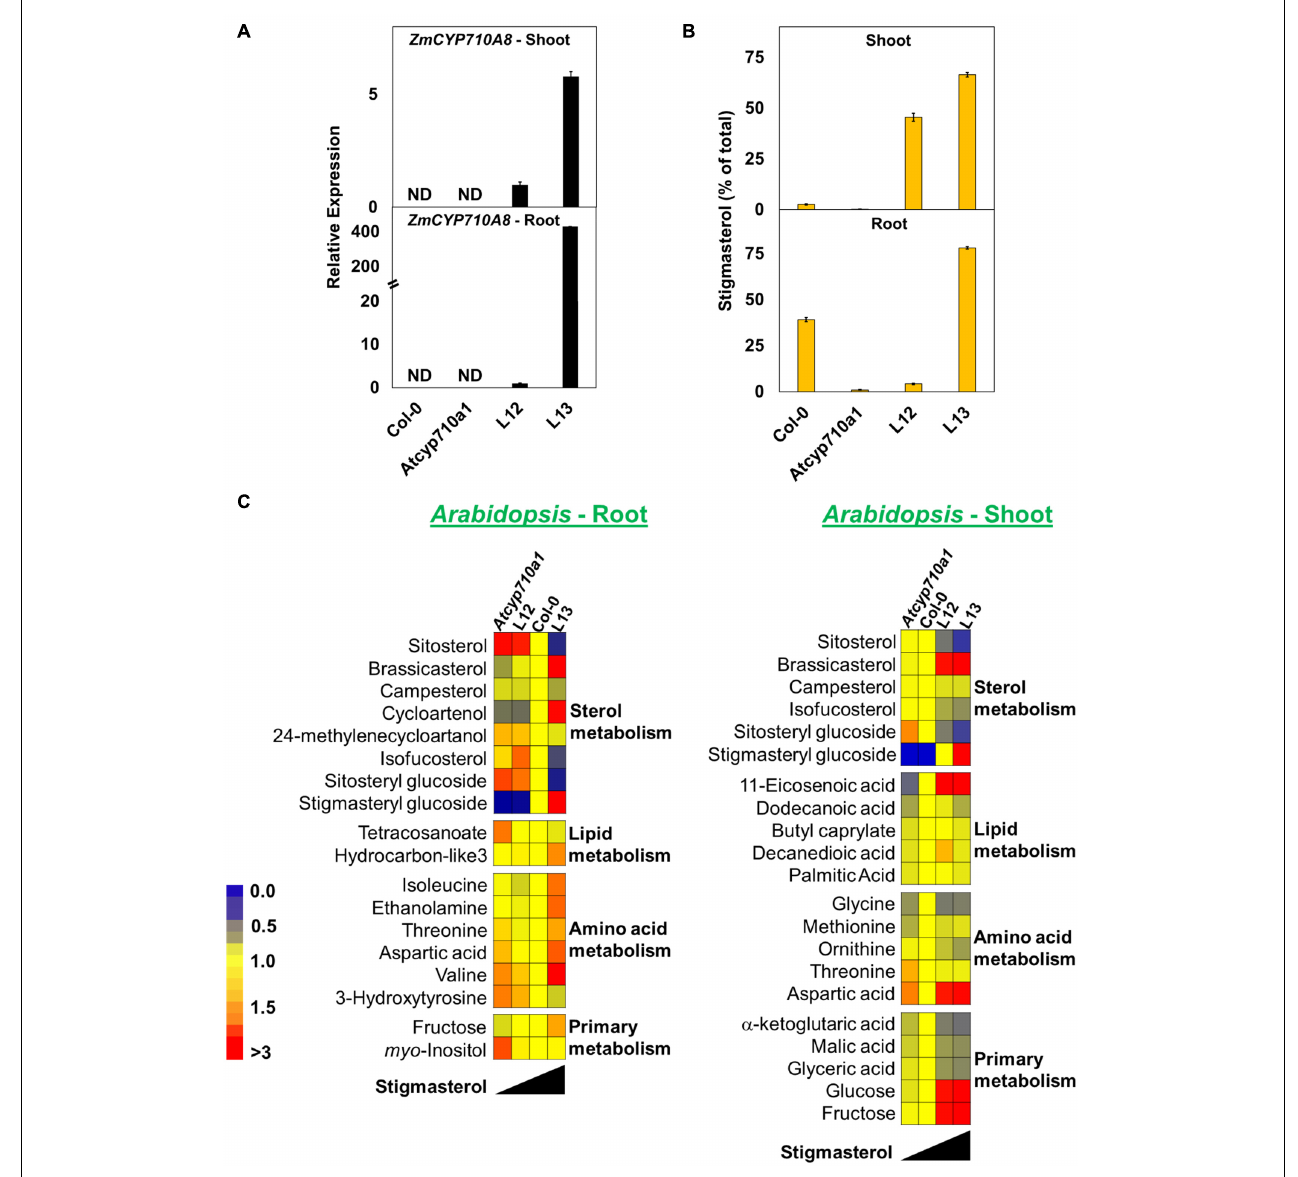
FIGURE 8 | Stigmasterol modification impacts metabolite profile in root and shoot tissues of Arabidopsis Atcyp710a1 expressing ZmCYP710A8. (A) Relative quantification of ZmCYP710A8 mRNA in two independent Arabidopsis lines (L12 and L13) expressing the 35S:ZmCYP710A8 construct ( Figure 2B ) in Atcyp710a1 background. Root and shoot tissue samples were separately pooled from > 100 seedlings (3-week-old) grown in magenta boxes as described in section “Materials and Methods.” Data are means ± SD of three replicates. AtEF1 α -A was used as a reference gene for normalization to be consistent with other occurrences. ND, not detected. (B) The composition (% of total sterols) of stigmasterol in root and shoot of Col-0, Atcyp710a1 mutant and lines L12 and L13 (as in panel A ) are shown. Tissue samples were pooled from > 100 seedlings (3-week-old) grown in magenta boxes as described in section “Materials and Methods.” Roots and shoots were harvested separately from one box for a biological replicate. Data are means ± SD from three biological replicates. (C) Non-targeted metabolite profile from roots and shoots of Col-0, Atcyp710a1 mutant and lines L12 and L13 were analyzed as described in section “Materials and Methods.” Relative metabolite levels compared to wild type are shown as fold changes in roots and shoots. The colors indicate the degree of fold change relative to wild type as shown in the color